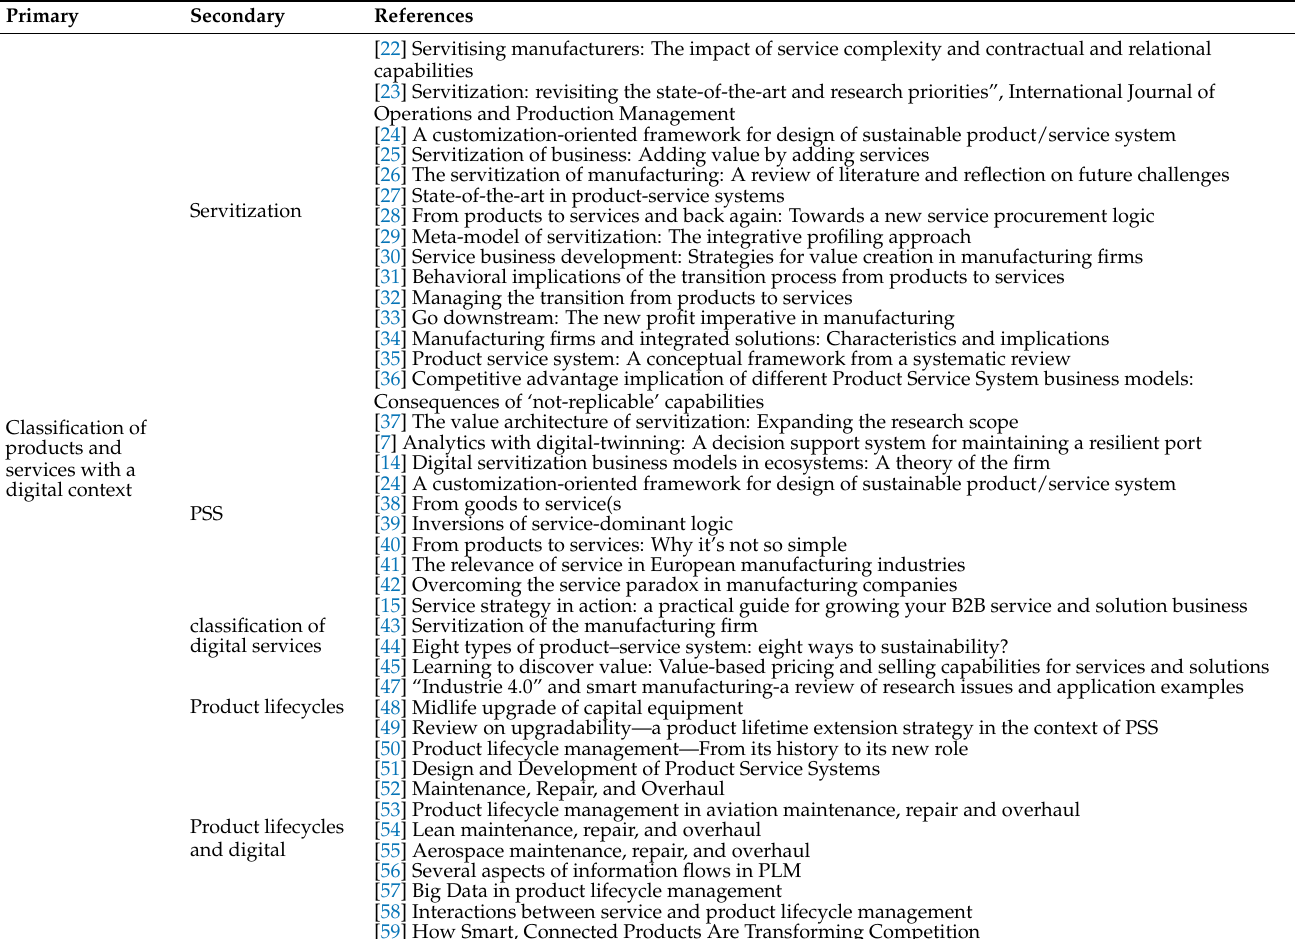
Table A1. Breakdown of the literature used in the literature